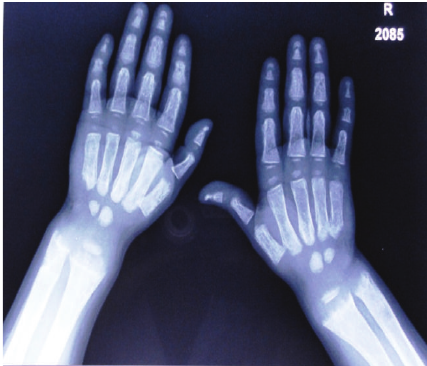
Figure 17: Wrist radiograph.